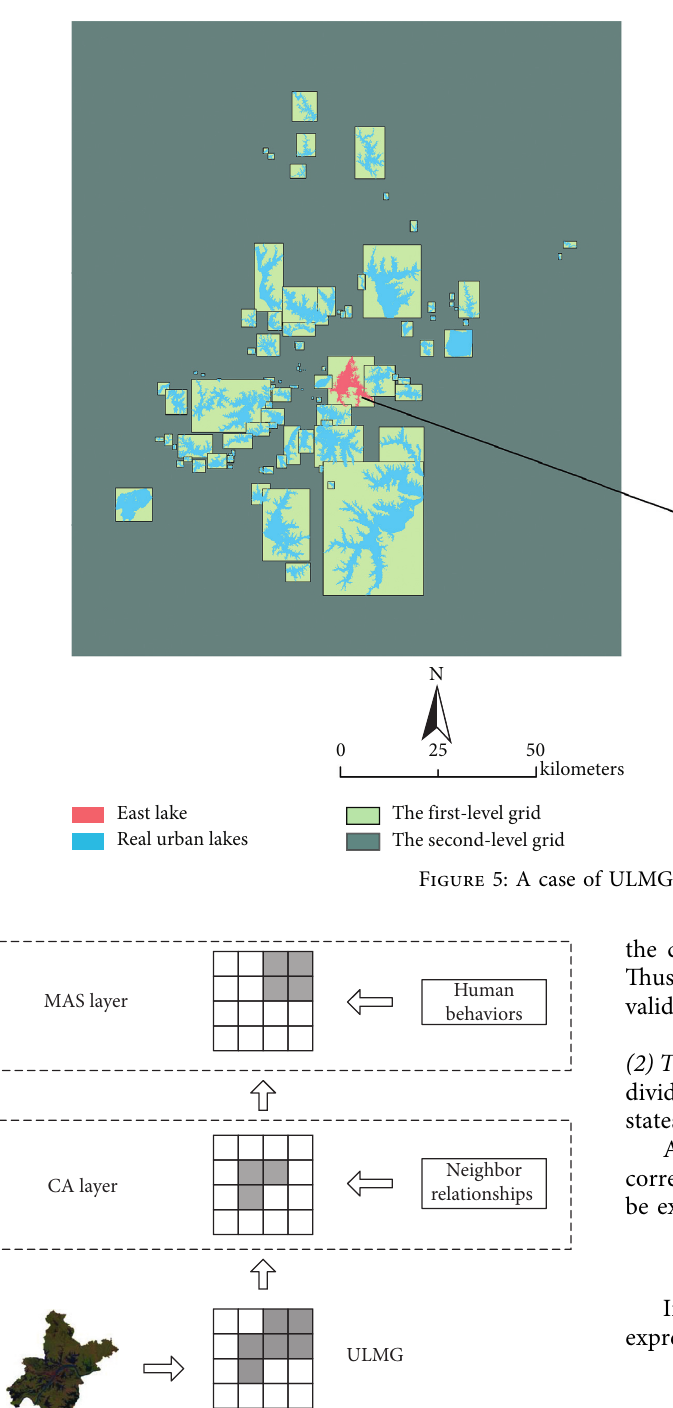
Figure 6: The structure of DULAEM. CA layer and MAS layer are integrated upon